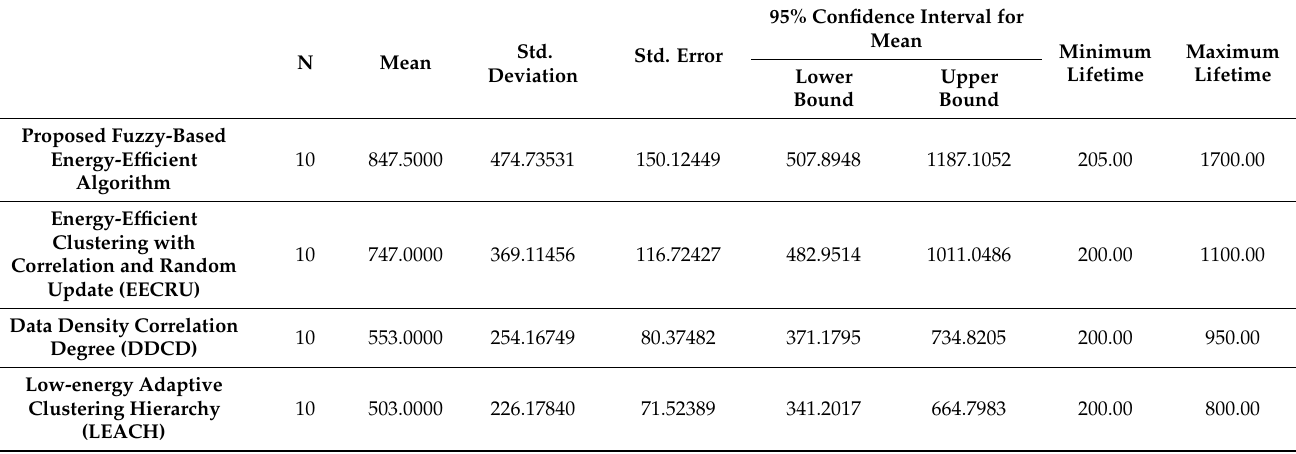
Table 3. Descriptive statistics of network